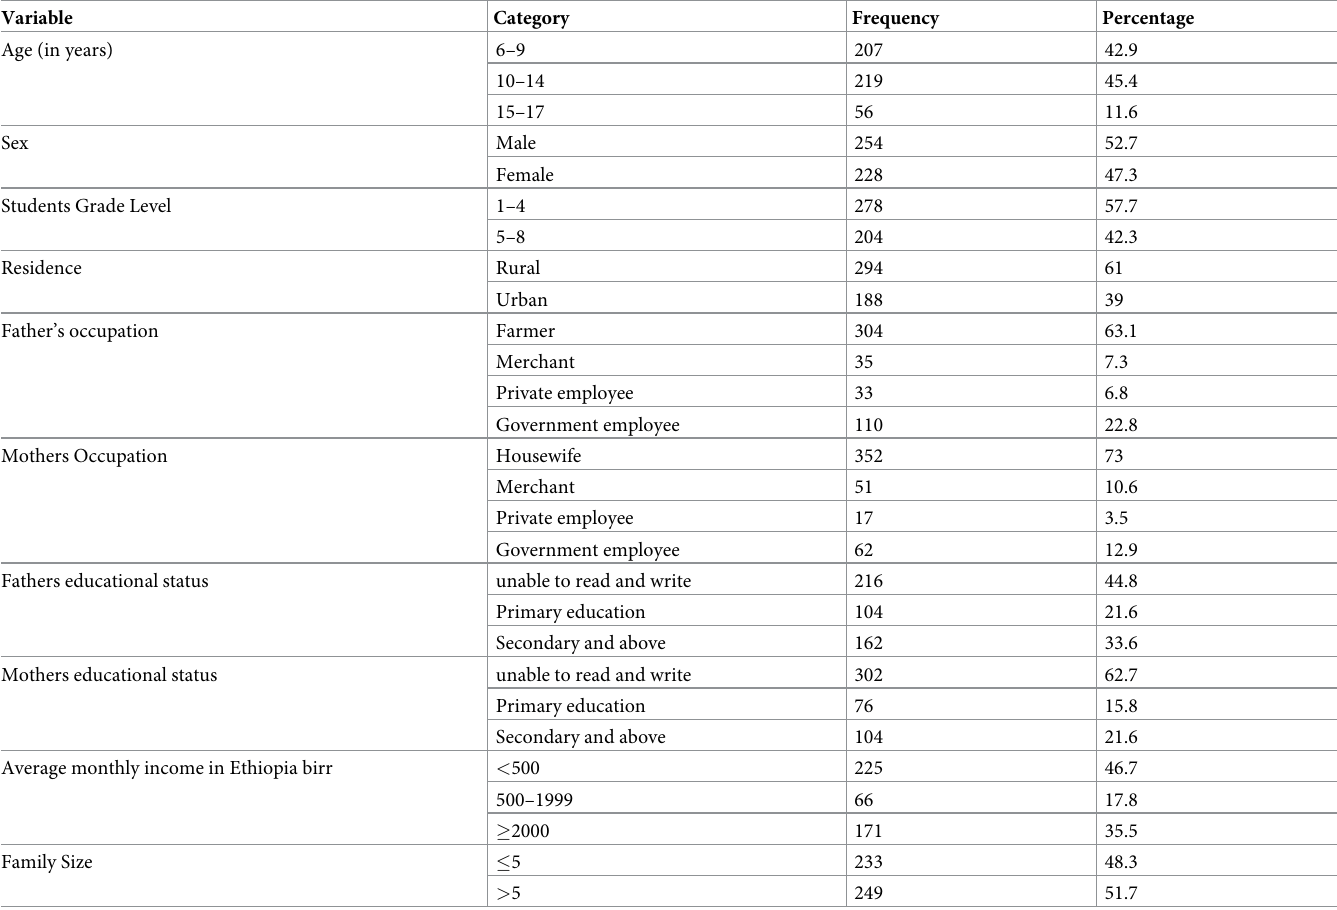
Table 1. Sociodemographic characteristics of parents/legal guardians and school children in Kersa Woreda primary schools, eastern Ethiopia, 2020/21(n =